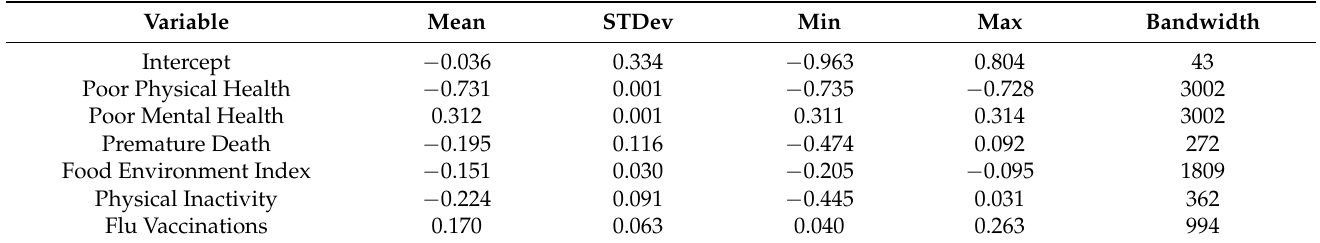
Table 4. MGWR Results for the Spatial Variability of Parameters using Adaptive